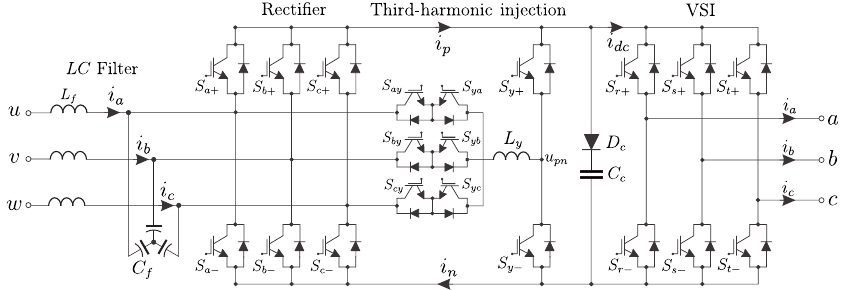
Figure 24. Two-stage matrix converter with third-harmonic injection.